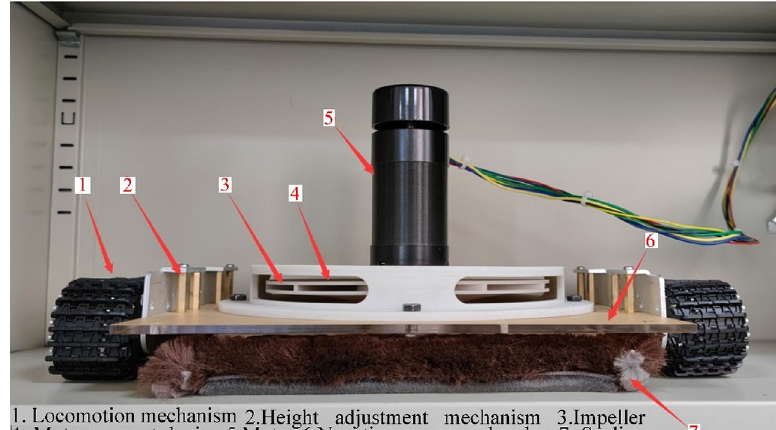
Figure 7. Experimental prototype of wall-climbing robot.